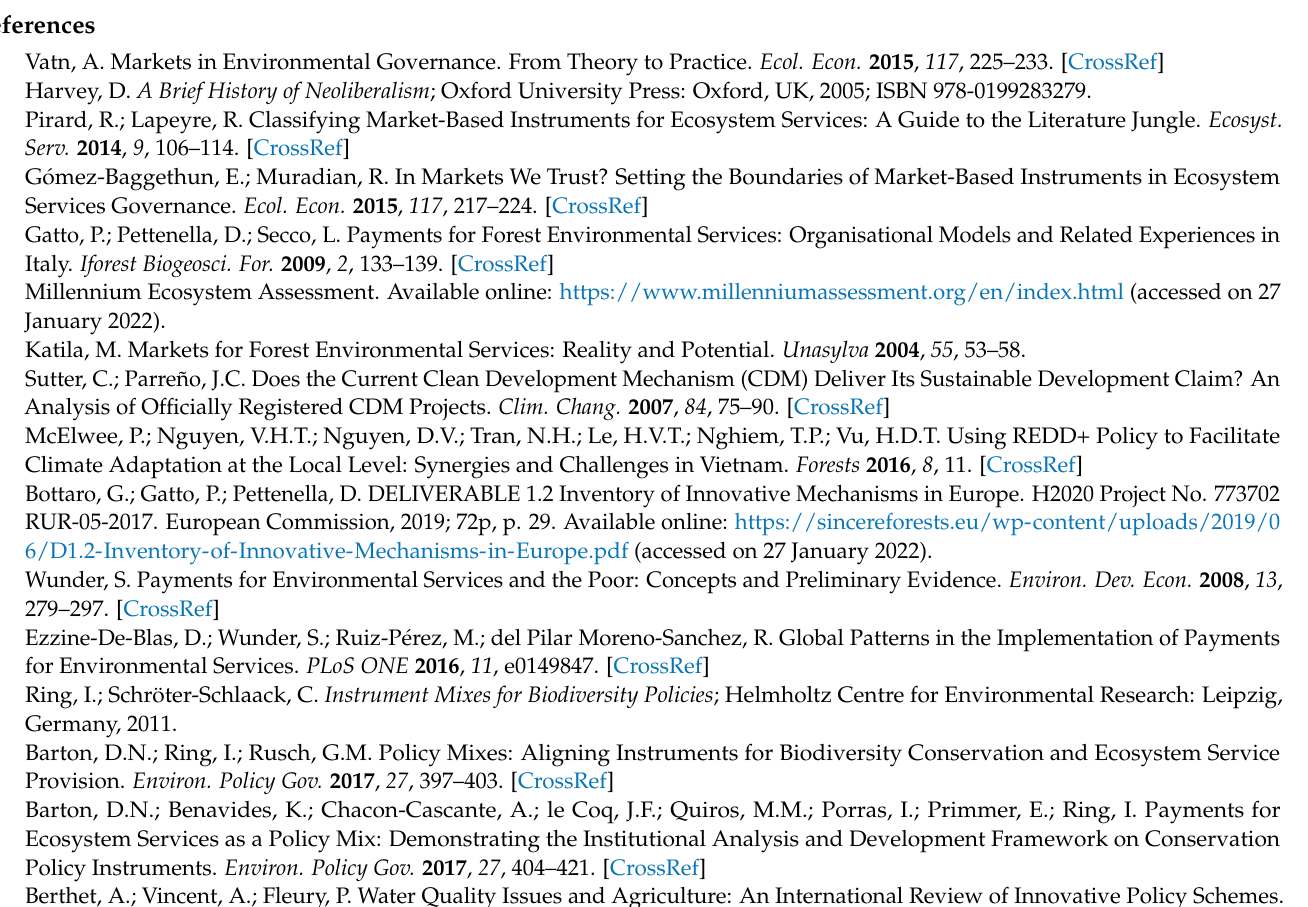
Table S2: Frequency and proportion of actors involved in the reviewed mechanisms (in some cases, there are multiple buyers or intermediaries participating in the mechanisms); Table S3: Description of variables used in the cluster analysis; Table S4: Principal Component (PC) extraction (eigenvalues and variance explained of the first seven PCs) and factor loadings (only loadings of the first five PCs are reported); Supplementary Material File S2: Inventory of forest carbon mechanisms using market-based